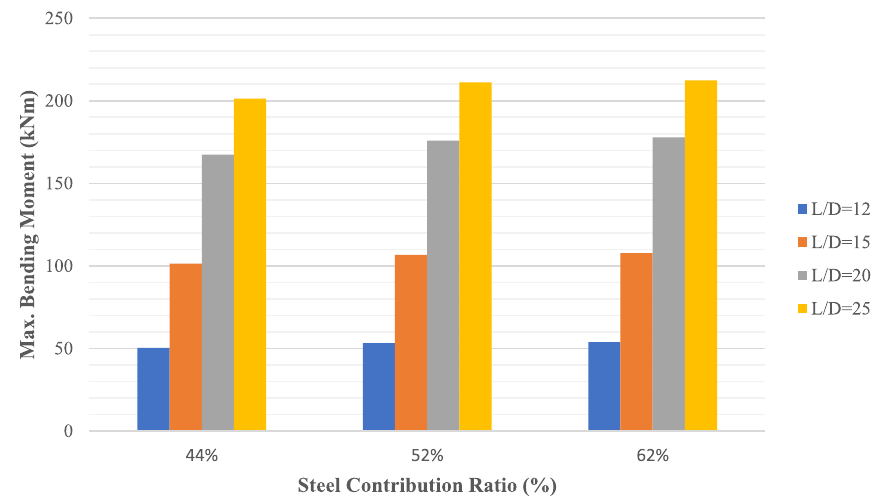
Fig. 7 Effect of structural steel contribution ratio on maximum bending moment for eccentricity of